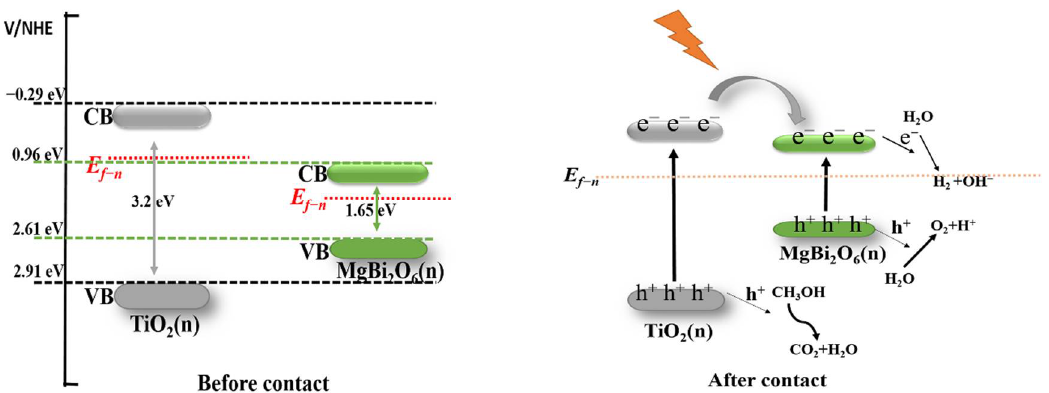
Figure 9. Schematic energy band diagrams of the MBO/TiO 2 n - n heterojunction and the possible photocatalytic mechanism of hydrogen production.